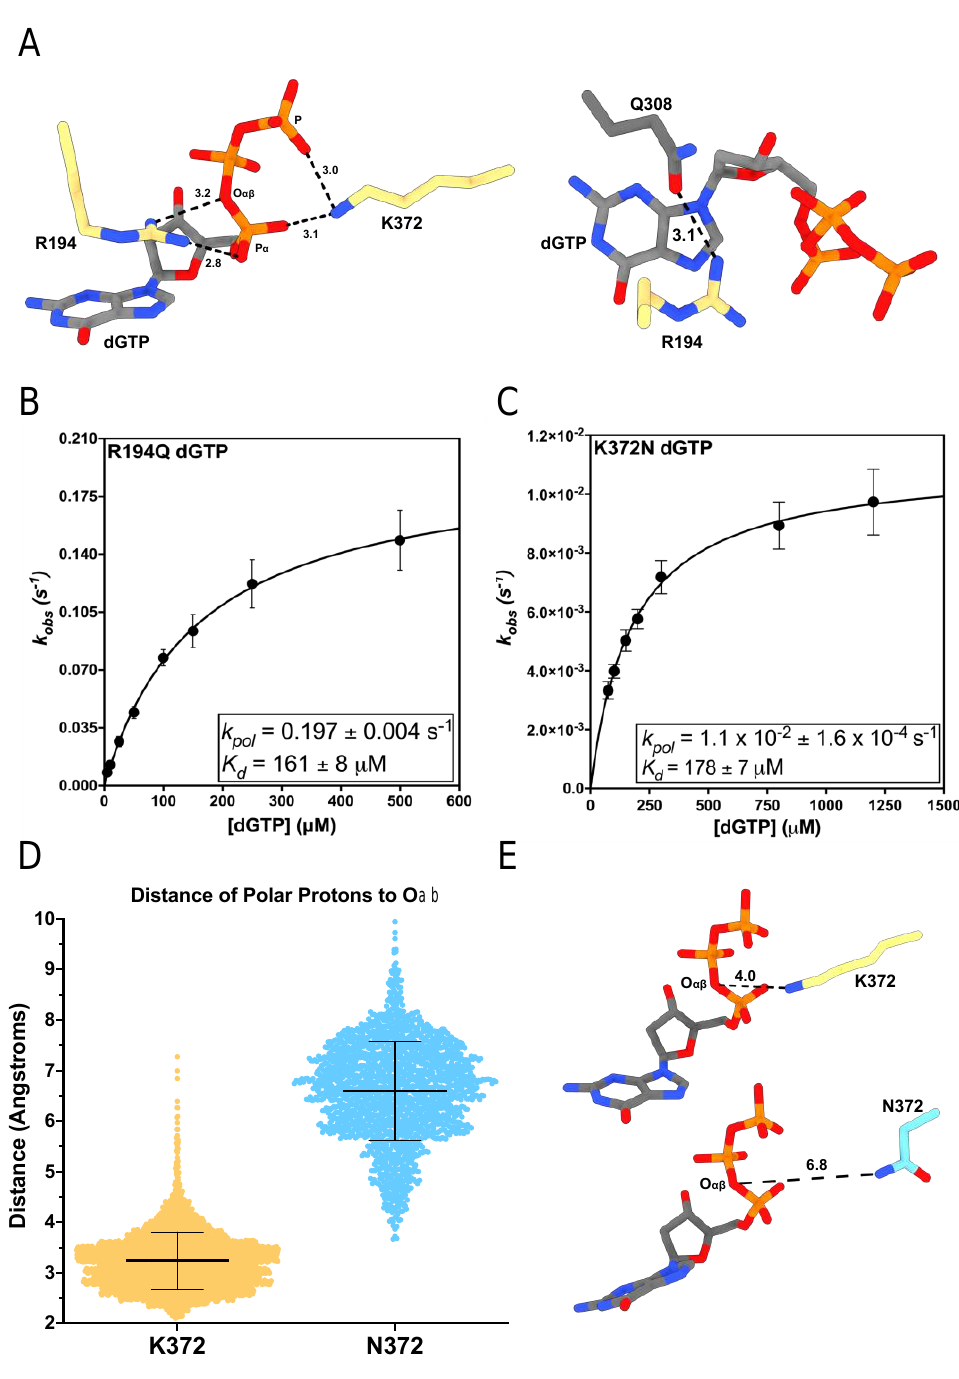
Figure 2. Mechanism of R194Q and K372N nucleotide insertion. ( A ) Interactions of R194 and K372 with the incoming dGTP and R194’s interaction with Q308 (PDB: 7KQN). ( B ) Replot of k obs values from single-turnover kinetics of R194Q inserting dGTP with the k pol and K d indicated. ( C ) Replot of k obs values for K372N inserting dGTP with the k pol and K d indicated. ( D ) Distances between the polar protons of K372 for WT (yellow) and N372 for K372N (cyan) and O αβ of the incoming nucleotide. The average distance is indicated by the central black line and error bars represent the standard deviation of the mean. ( E ) Representative structures of WT and K372N, indicating the average positioning of the polar heavy atom for residue 372 in relation to O αβ . The distance between the nonhydrogen atom closest to O αβ for WT (yellow) and K372N (cyan) is represented with black dashes and measured in